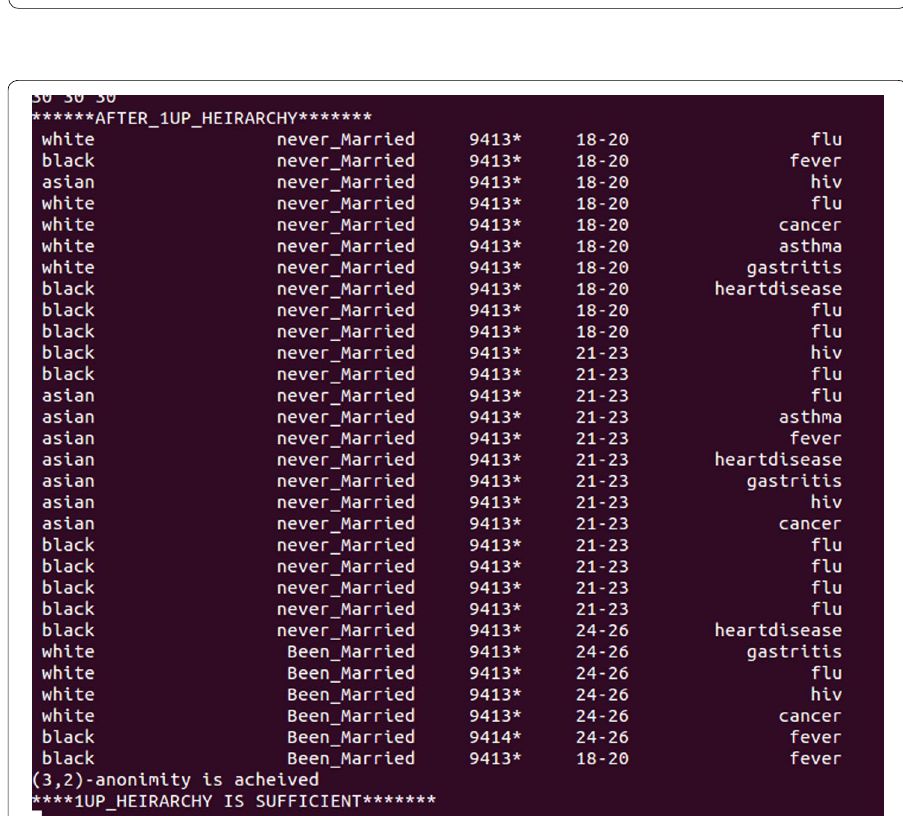
Fig. 8 Anonymization with 1-up